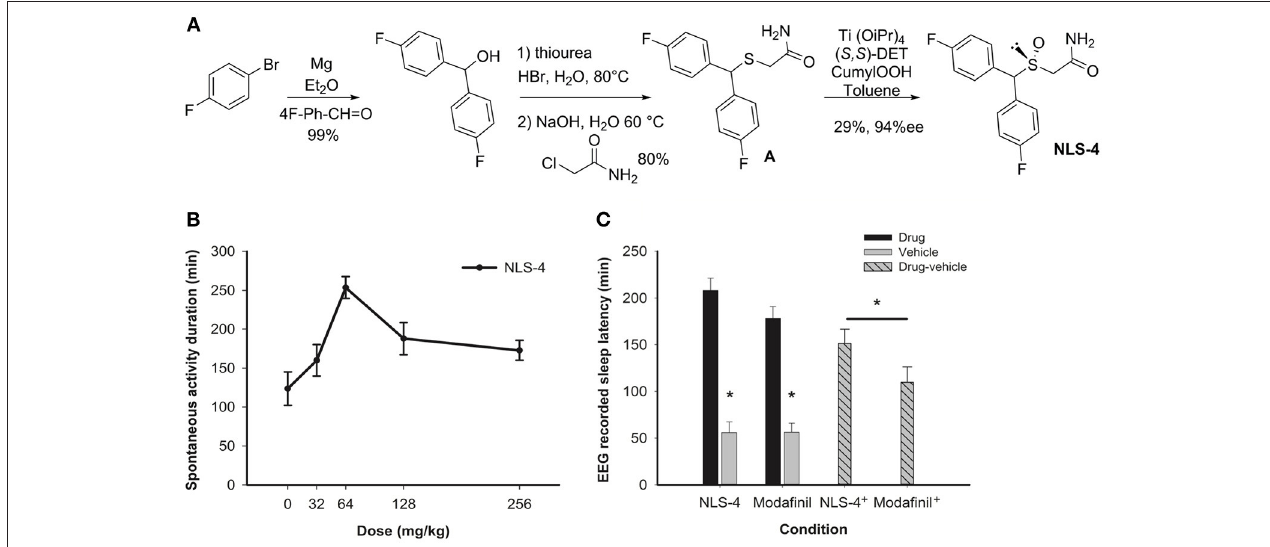
FIGURE 1 | (A) NLS-4 was synthesized through a straightforward method involving first a Grignard addition of the desired 4-fluorophenylmagnesium bromide onto 4-fluorobenzaldehyde to provide p-fluorobenzydrol. Addition of thiourea in bromohydric medium, followed by treatment of the thiourea adduct with aqueous NaOH and alkylation with 2-chloroacetamide afforded intermediate “A.” Finally, asymmetric oxidation of thioether “A” into ( R )-sulfoxide by using Kagan method (Pitchen and Kagan, 1984 ) led to expected NLS-4 compound in 23% overall yield in 4 steps (Cao et al., 2010). (B) Amount of spontaneous locomotor activity measured after intraperitoneal administration of increasing doses of NLS-4 at light onset ( N = 8). (C) Duration of EEG recorded wakefulness after administration of 64 mg/kg of NLS-4, 150 mg/kg of modafinil, or vehicle. Both drugs significantly increased the amount of wakefulness (paierd t -test, * P < 0.05) but NLS-4-induced wake duration